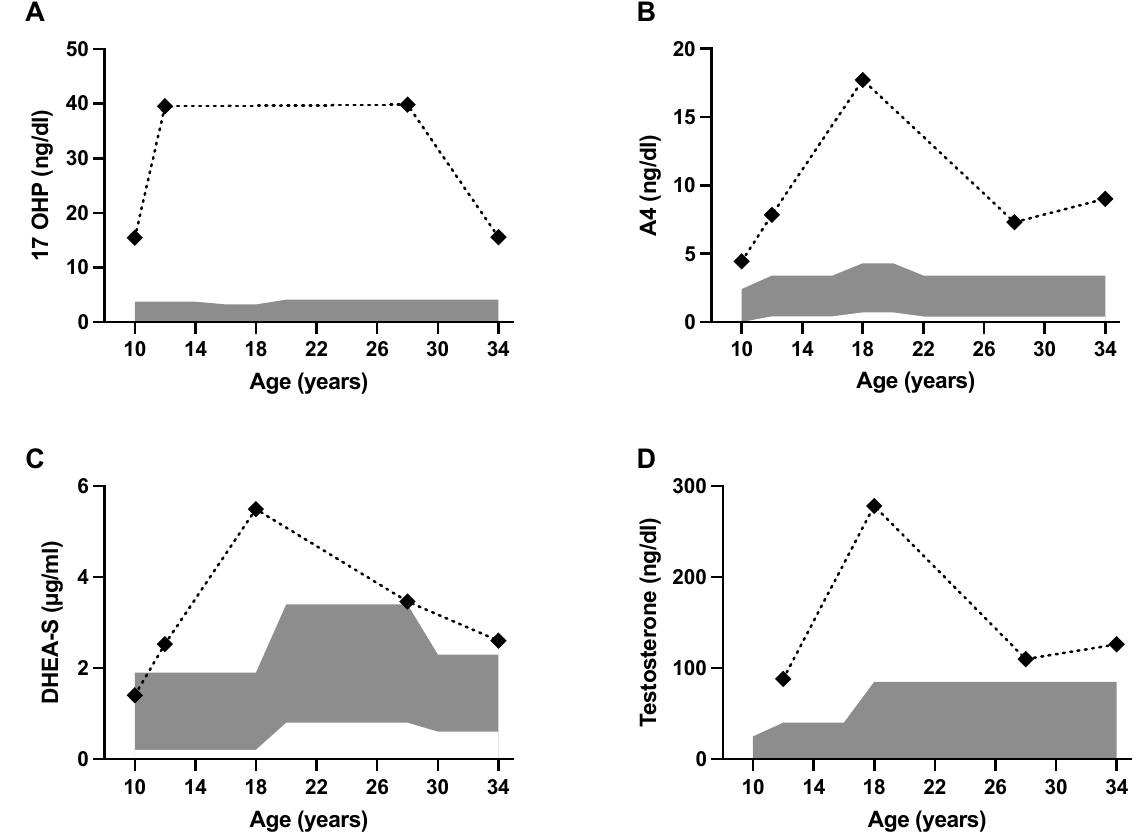
Figure 1. 17-OHP and androgen levels of the patients at different ages. Figure 1. 17 ‐ OHP and androgen levels of the patients at different ages. Graphical representation of increased 17-OHP and androgen levels of the patient at Graphical representation of increased 17 ‐ OHP and androgen levels of the patient at different ages, depicted as black data points in relation to sex- and age-specific different ages, depicted as black data points in relation to sex ‐ and age ‐ specific reference